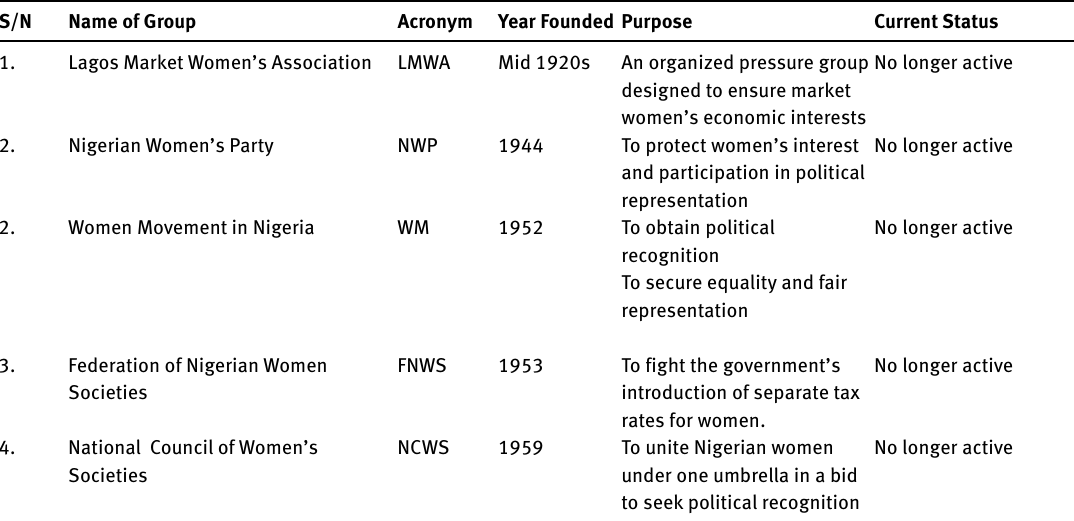
Table 1: Notable women groups in the Pre-independence